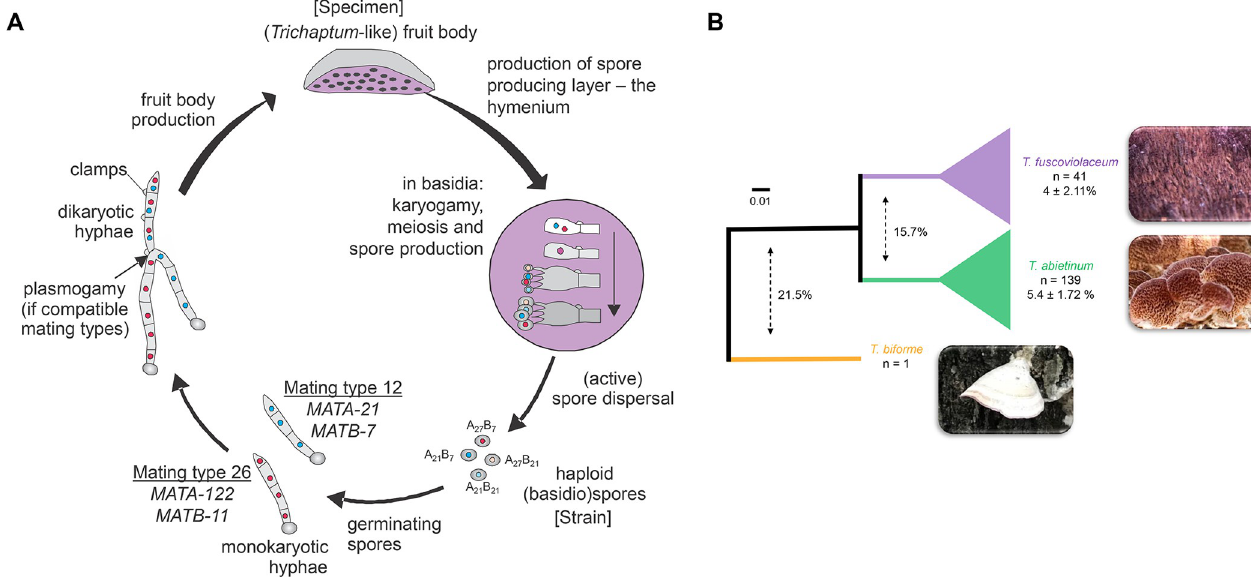
Fig 1. Trichaptum abietinum and T. fuscoviolaceum are sister-species. A) Schematic representation of the Trichaptum life cycle. As an example, MATA and MATB types, generating two compatible mating types are indicated. A specimen was the original dikaryotic sample, i.e. TA[Number], isolated from the wild environment and stored in a national museum or in our laboratory. Strains were isolated from fruiting bodies and due to their monokaryotic character, we added an M[Number] to the specimen name, TA[Number]M[Number]. Strains are stored in our personal collection at -80˚C. B) Schematic Neighbor-Joining (NJ) phylogenetic tree reconstructed using (100 –ANI)/100 values. ANI values go from 100% (identical genomes) to 0% (distinct genomes). In a format (100 – ANI)/100, these values represent divergence. Full NJ and ASTRAL phylogenetic trees can be found in S1 Fig and in iTOL: https://itol.embl.de/shared/Peris_D. The number of strains (n) and the average (100 –ANI)/100 within species are indicated for each species clade. The L15831 genome is included increasing the T . abietinum collection to 139 strains. Dashed arrows indicate the average (100 –ANI)/100 of pairwise strain comparisons for the compared species. Colors highlight the species designation after the whole genome sequencing analysis.